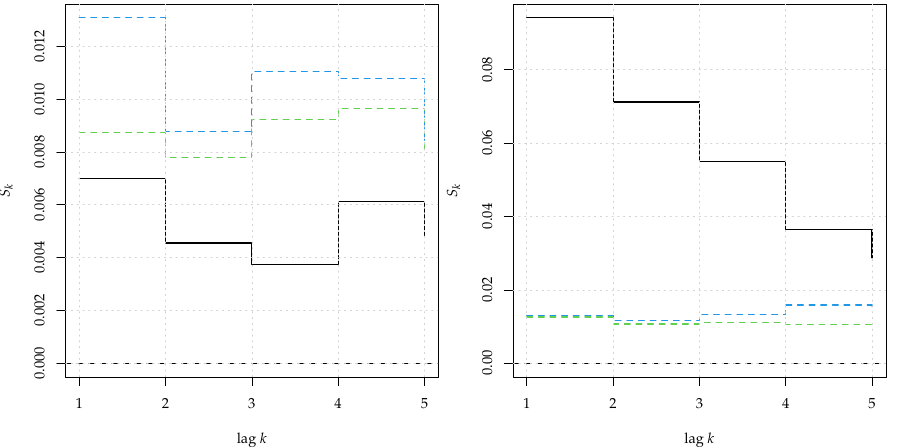
Figure 6. Serial Entropy S k for k = 1, . . . ,5 (black, solid line) computed on a realization from a white noise (left panel) and a AR(1) process (right panel). The rejection bands at 95% (green dashed line) and 99% (blue dashed line) correspond to the null hypothesis of serial